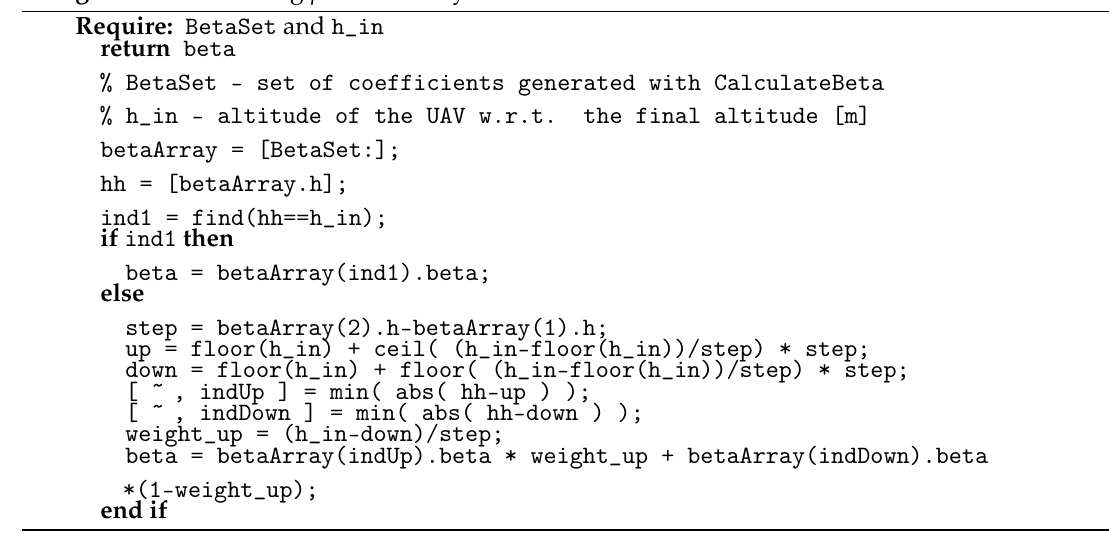
Algorithm A2: Finding β for arbitrary